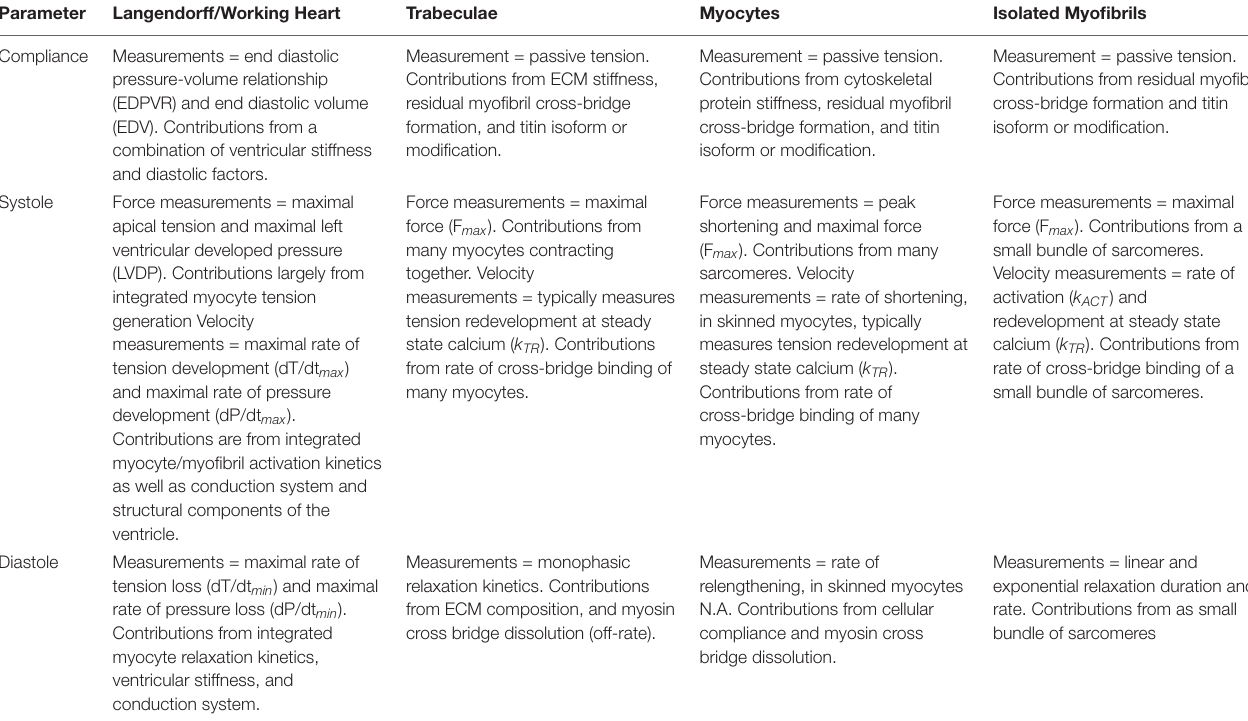
TABLE 1 | Summary of basic mechanical parameters and the ability of each mechanical assay to accurately address each parameter. Parameter Langendorff/Working